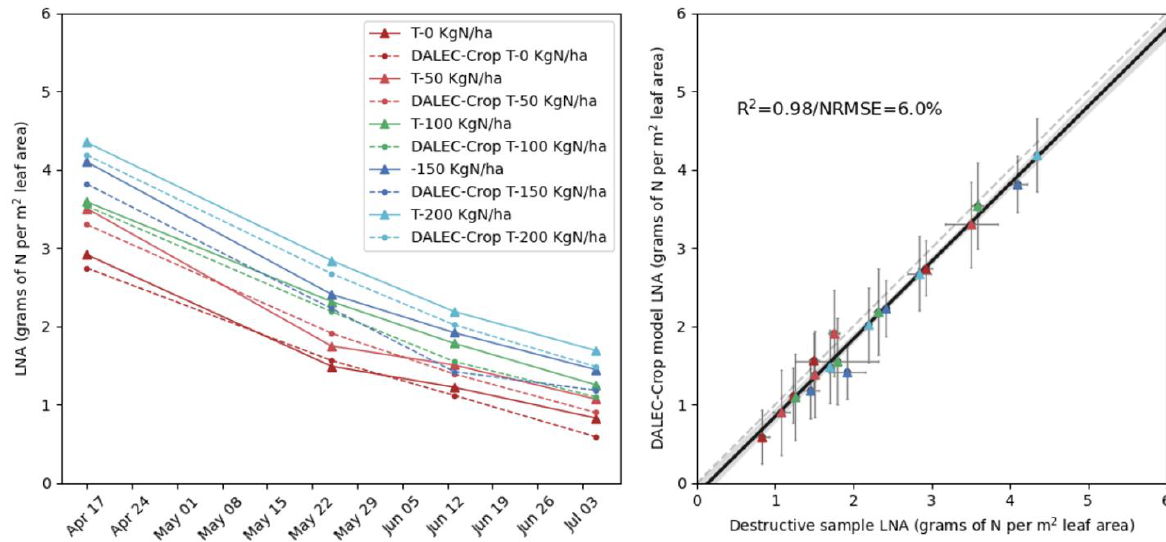
Figure 6. Experiment 1: Evaluating DALEC-Crop for the multi-temporal retrieval of leaf nitrogen per area (LNA) compared to LNA estimated from the 5 destructively sampled plots. Including a time-series comparison of model estimates (triangles) on dates corresponding to destructive LNA observations (dots) (left panel), and the linear-fit between all modelled and measured LNA values (solid black line), along with 1:1 line (grey dashed line) (right panel). Note: measured-model plot x-axis uncertainty error bars represent the difference between the high and low values from two replicated destructive samples, whereas the y-axis uncertainty is based on the standard deviation of the model estimates.